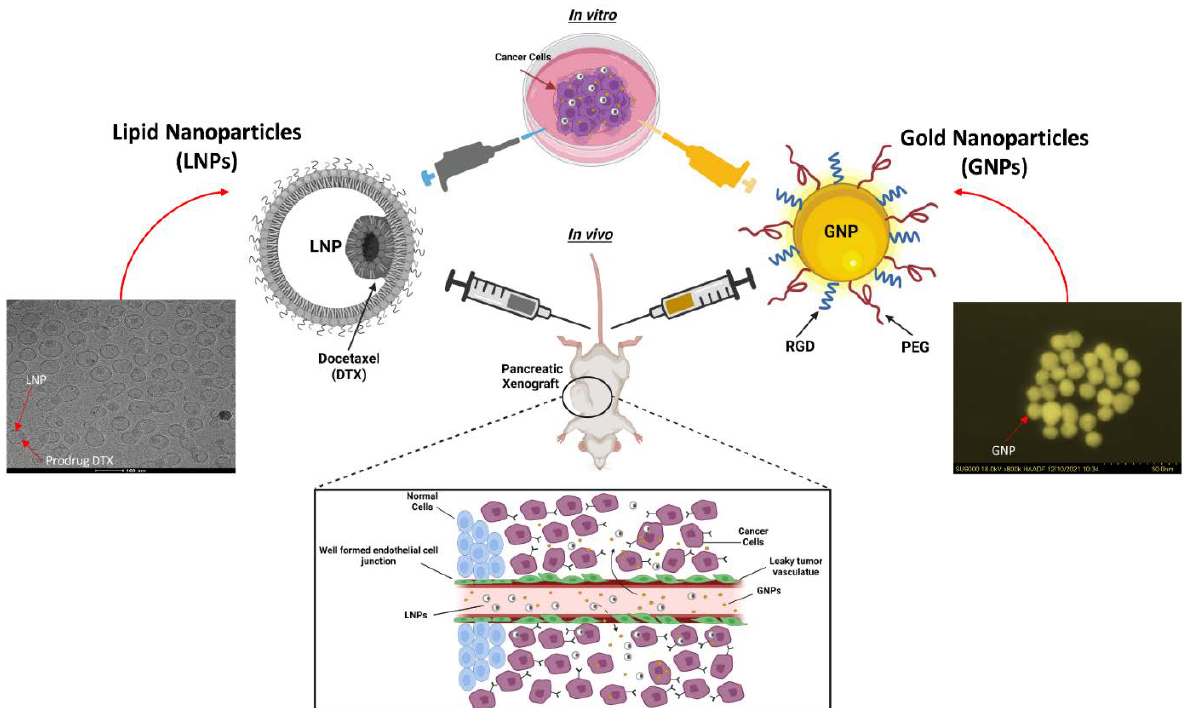
Figure 1. Schematic showing preclinical xenograft model to test the efficacy of a docetaxel (DTX) prodrug encapsulated in a lipid nanoparticle (LNP) and gold nanoparticle (GNP) combination vs. a 2D in vitro model with a high-angle annular darkfield (HAADF) image of GNP and a cryogenic transmission electron microscopy image of LNP DTX-P . The inset shows a schematic diagram of the escape of NPs from leaky blood vessels to tumour